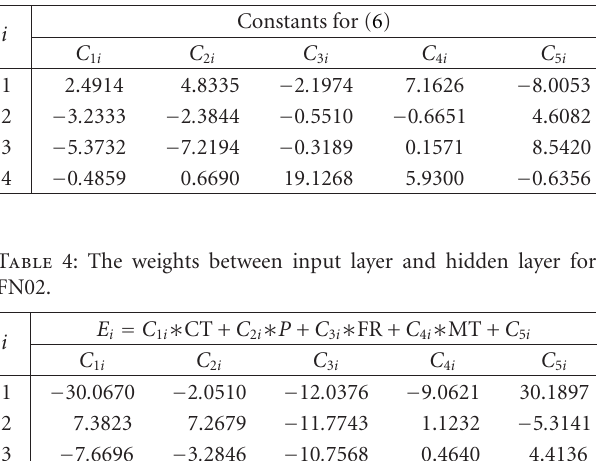
Table 3: Constants in (6) obtained by SCG algorithm with 4 neu- rons.